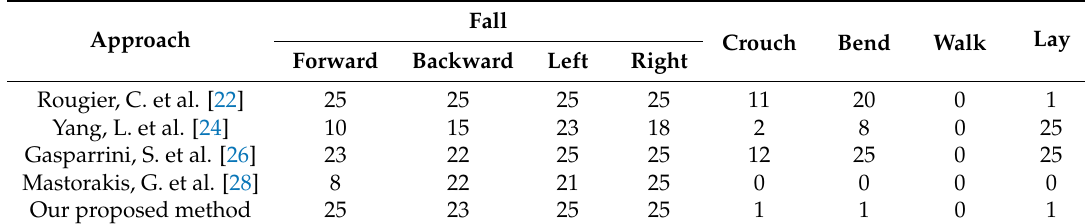
Table 3. Comparison of the fall detection capability on our self-collected dataset with other Kinect-based fall detection approaches.